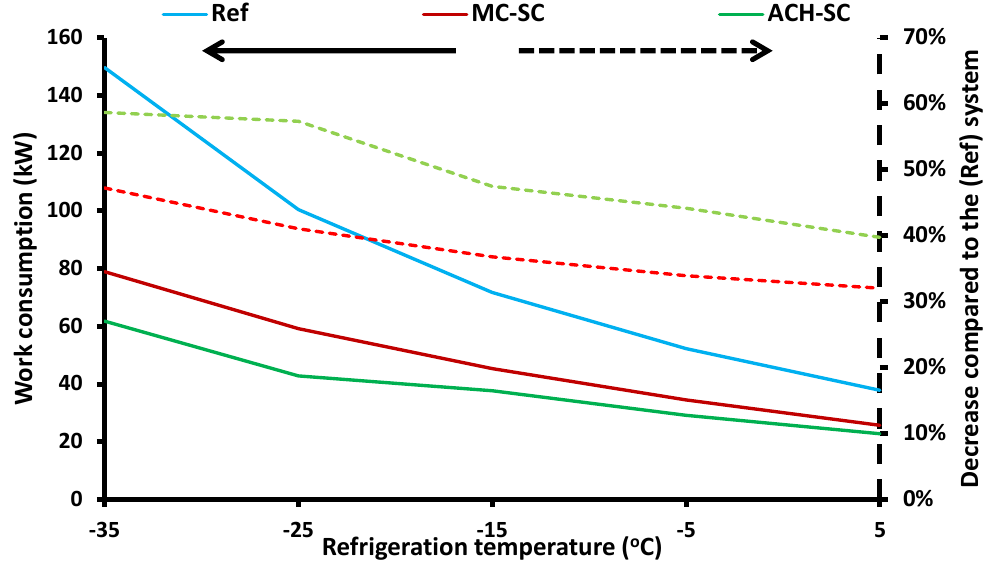
Figure 17. Work consumption of the optimized cases (continuous lines) of the three systems, and work consumption decrease of the subcooling cases compared to the reference case (non-continuous lines), (T c = 40 °C).